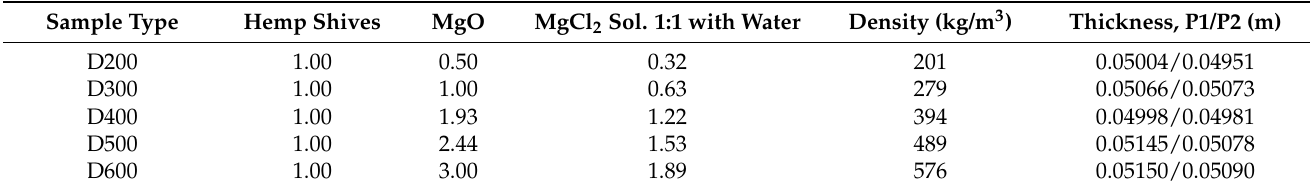
Table 1. Hemp composite mixed designs (mass proportions) and obtained densities (P1 and P2 denote samples of the same